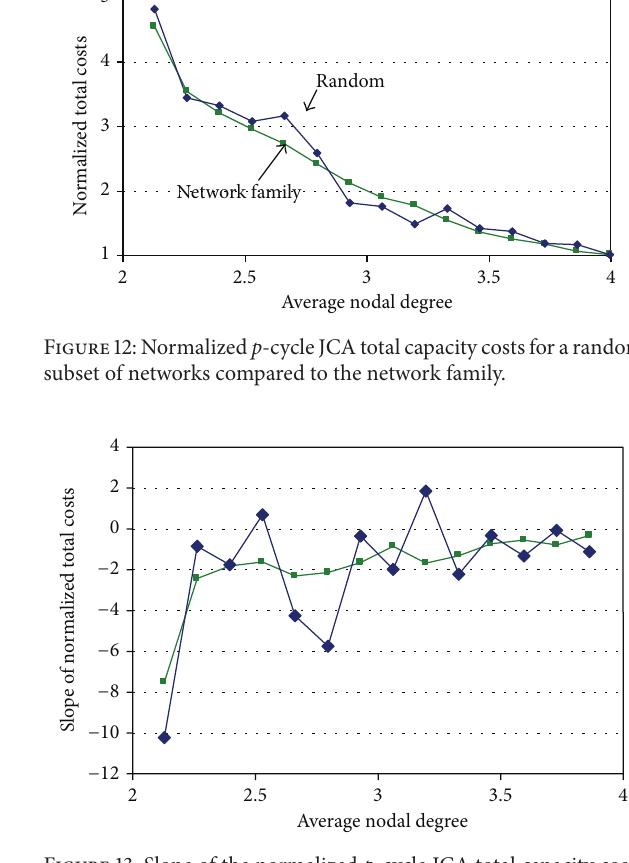
Figure 13: Slope of the normalized p -cycle JCA total capacity costs for a random subset of networks compared to the network